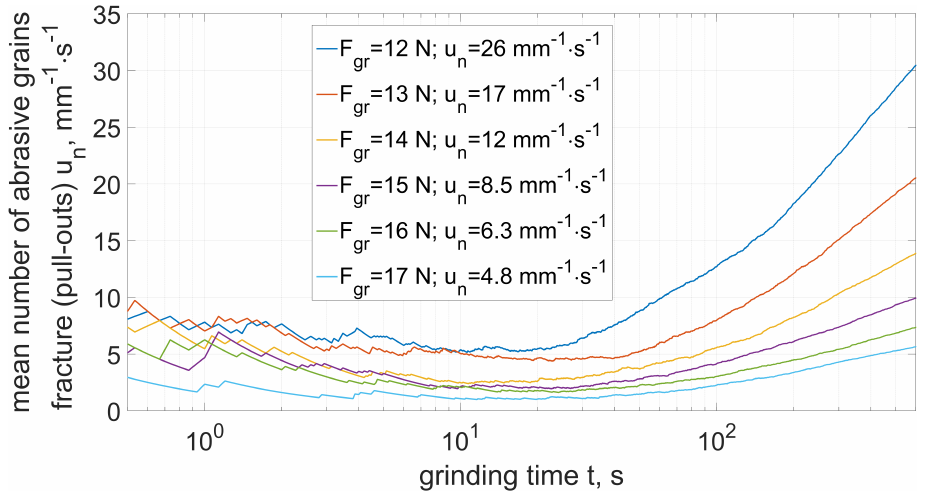
Figure 12. Mean number of abrasive grains fracture (pull-out) depending on grain strength (Equation (30))—case of high intensity (period from t 1 to t 2